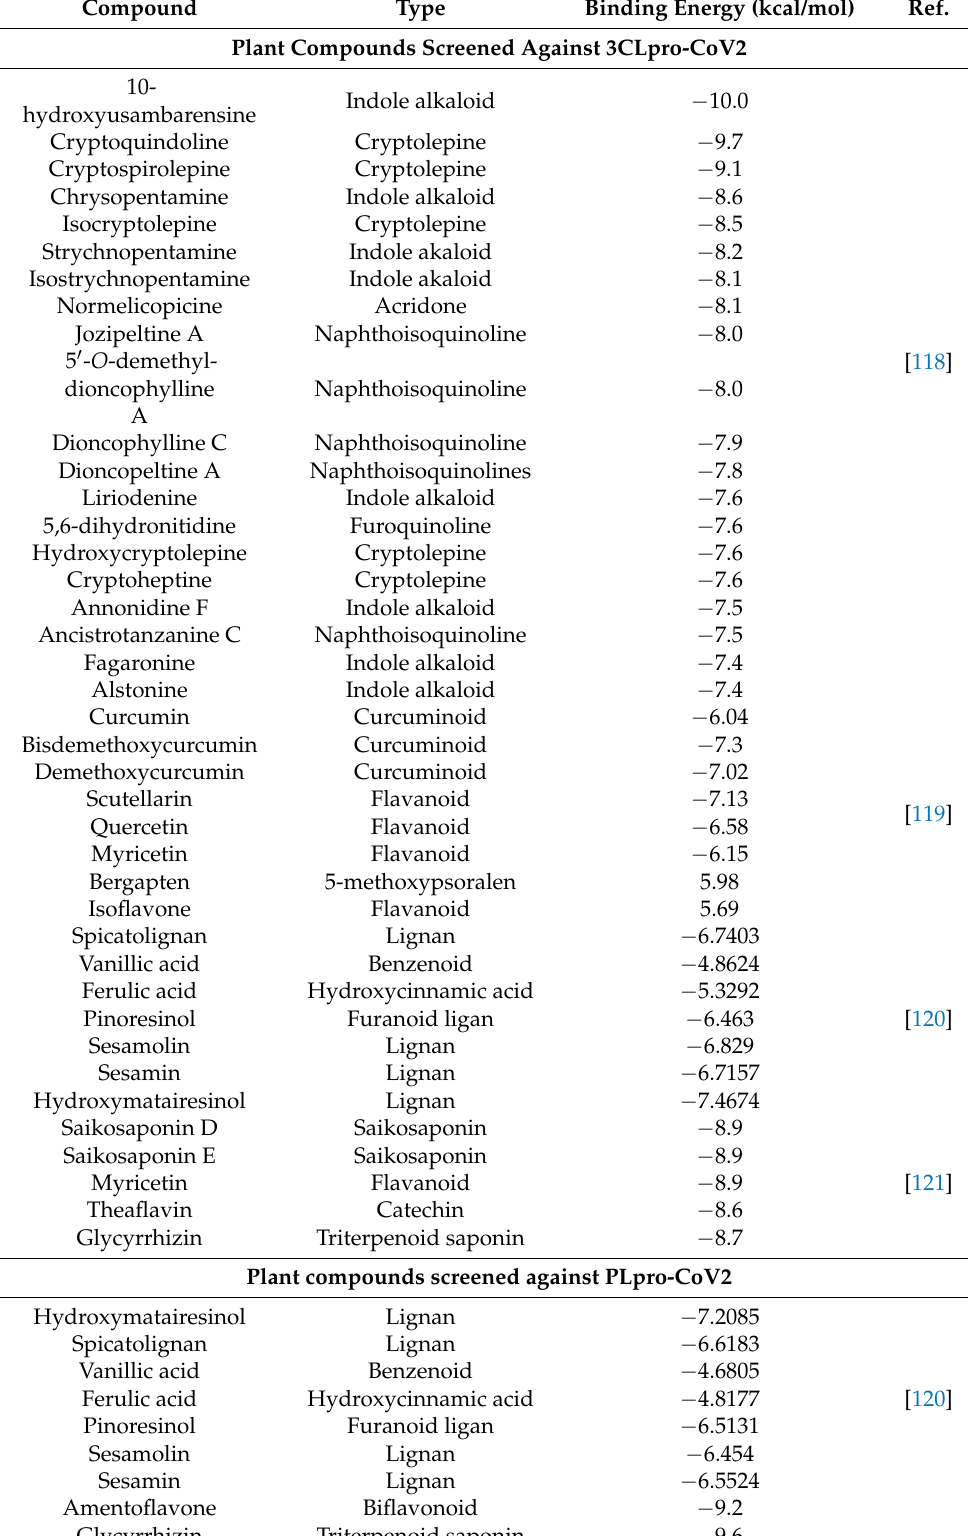
Table 3. Plant compounds thar are screened against SARS-CoV-2